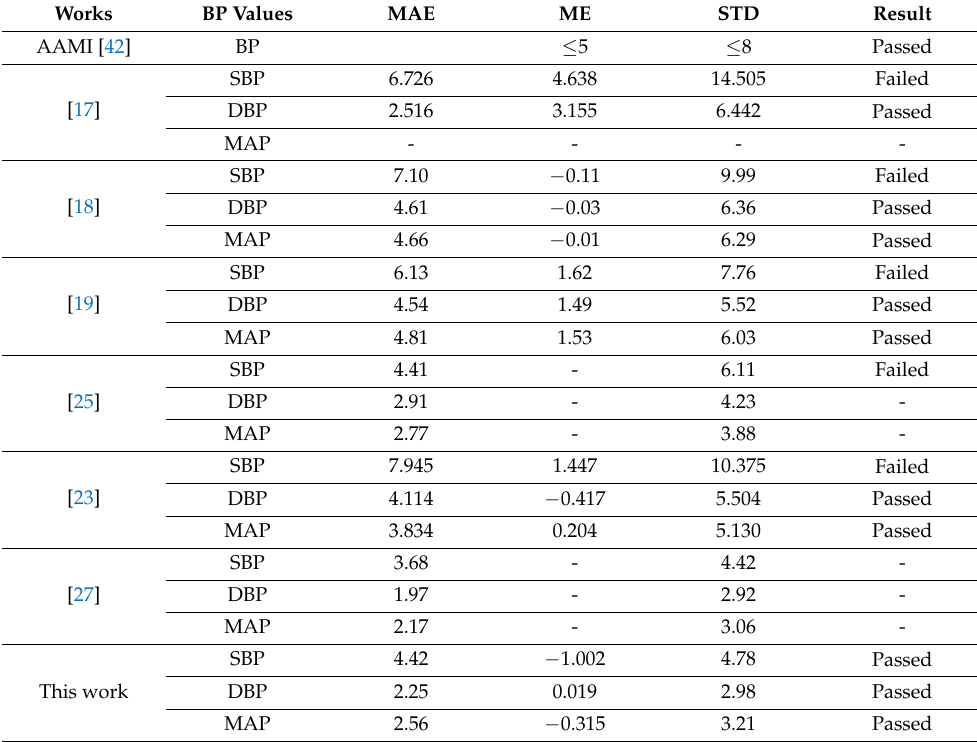
Table 3. Comparison with related works based on AAMI